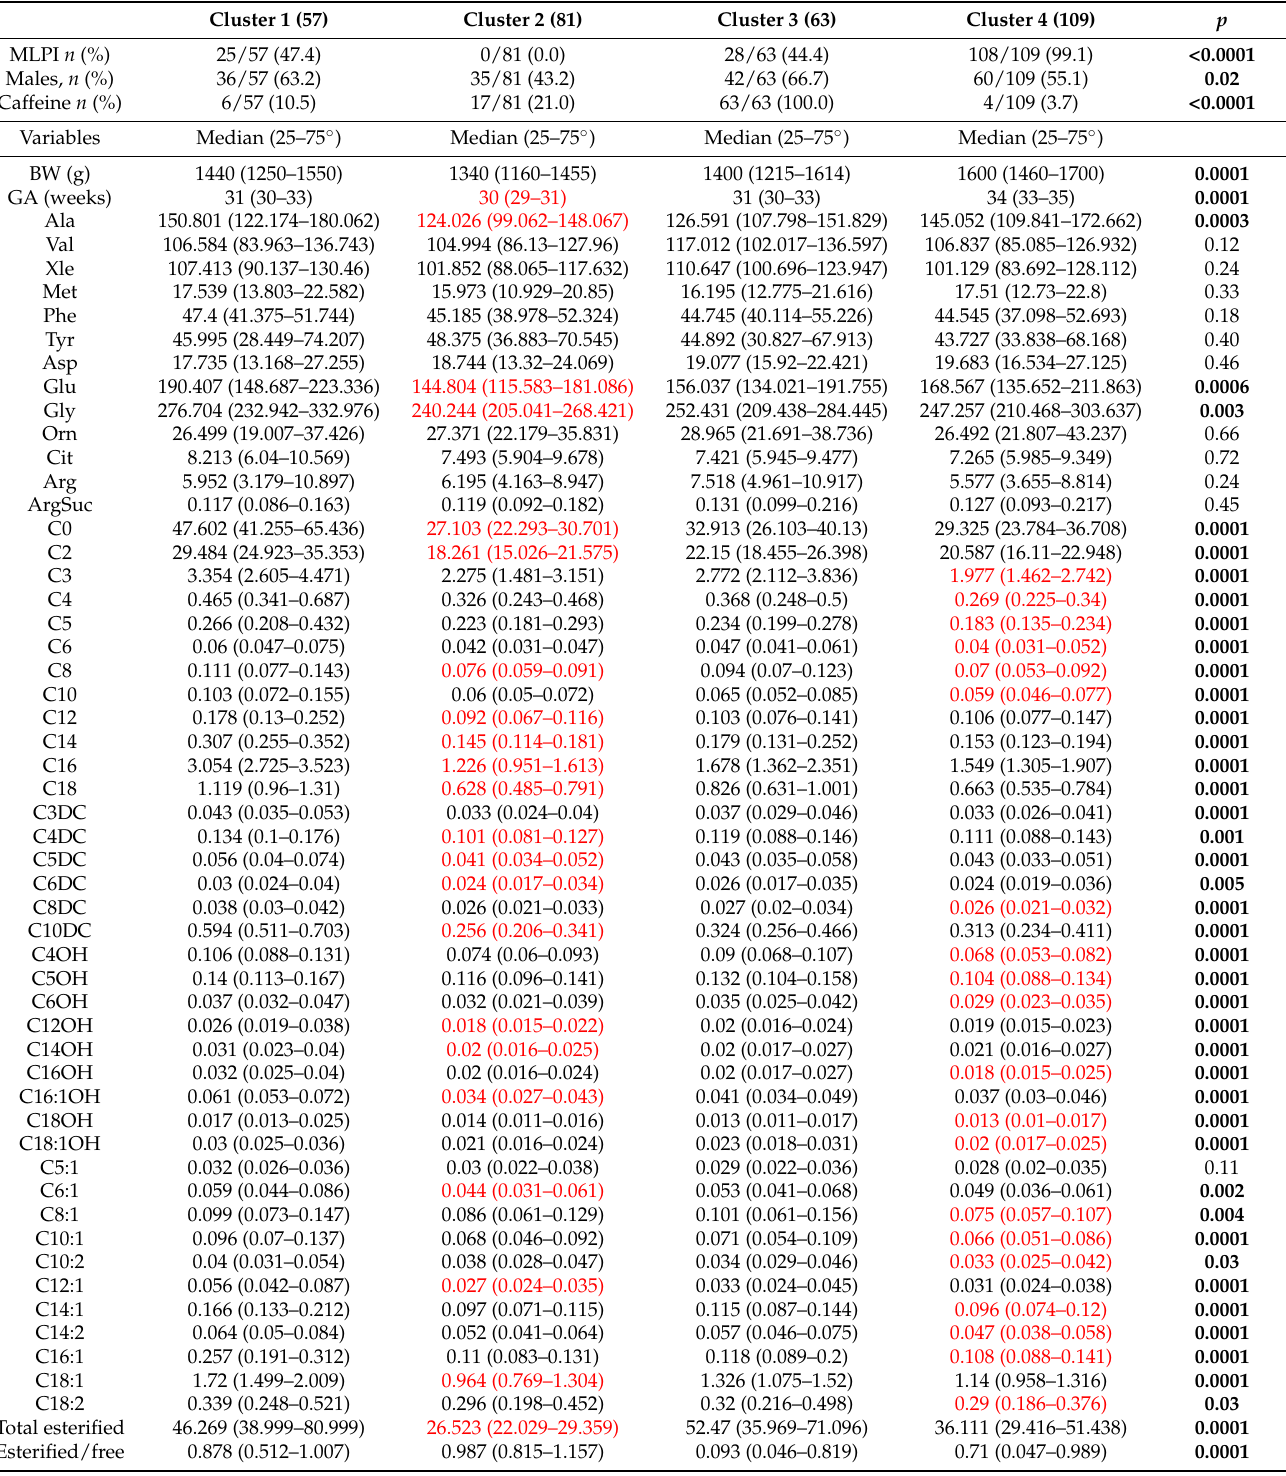
Table 5. Clusters analysis of